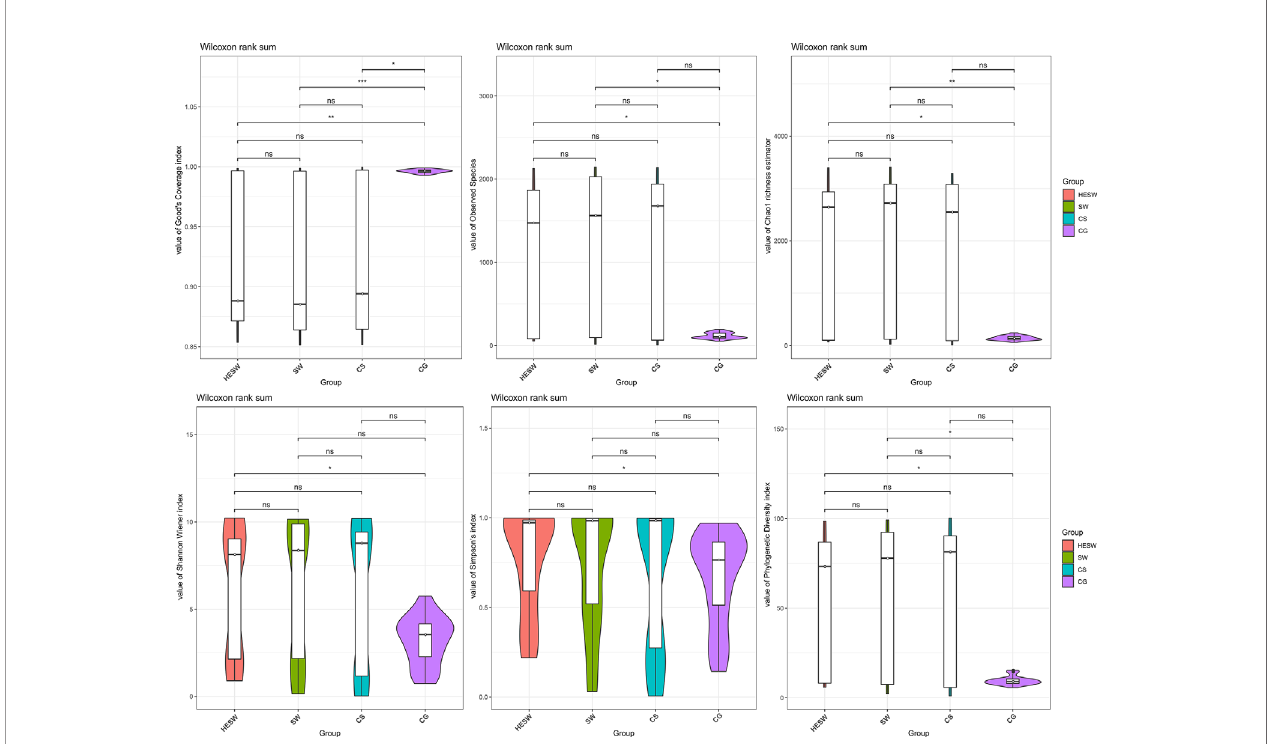
FIGURE 2 | On the dimensionality of alpha diversities, six indices all suggest the sort and richness of ocular bacterial microbiota from the healthy eyes of BK patients had signi fi cant difference from the eyes of healthy people. Alpha diversity indices in this study includes Good ’ s coverage index, Observed species, Chao1 index, Shannon Wiener index, Simpson ’ s index, and phylogenetic diversity index. (HESW, conjunctival swabs from the healthy eyes of BK patients; SW, conjunctival swabs from the diseased eyes of BK patients; CS, corneal scrapings from the diseased eyes of BK patients; CG, conjunctival swabs from healthy volunteers; ns, no signi fi cant